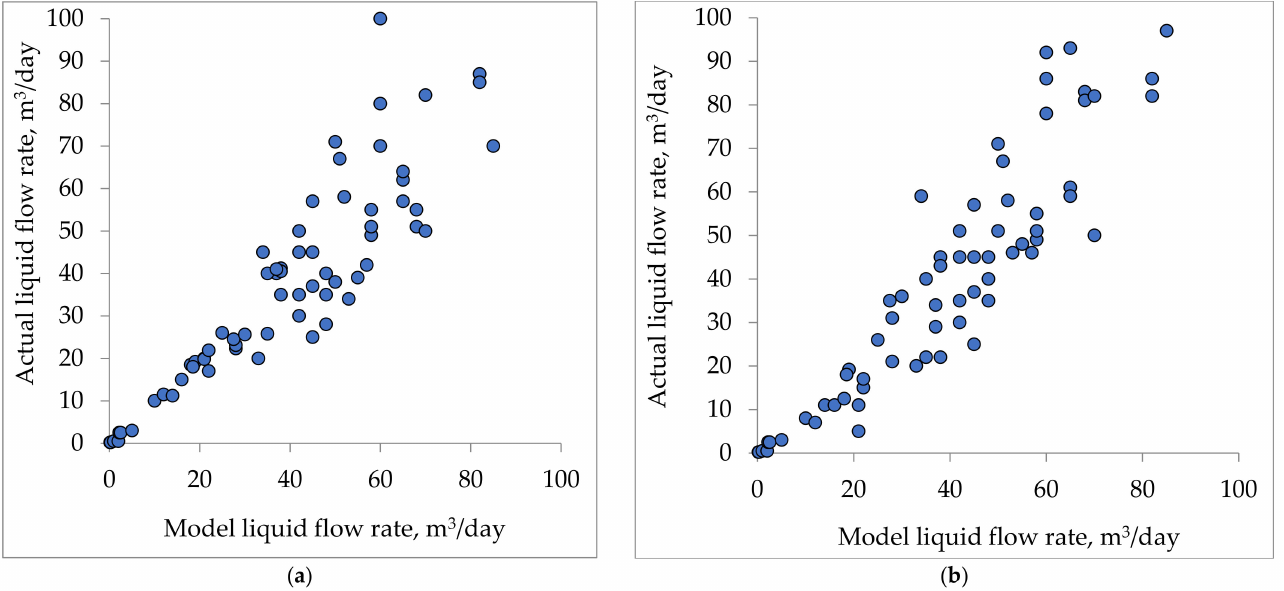
Figure 1. The correlation fields between the actual and model values of the liquid flow rates differentially depend on the values obtained when processing the data of the pressure build-up curve ( a ) and DCA ( b ) (terrigenous deposits)